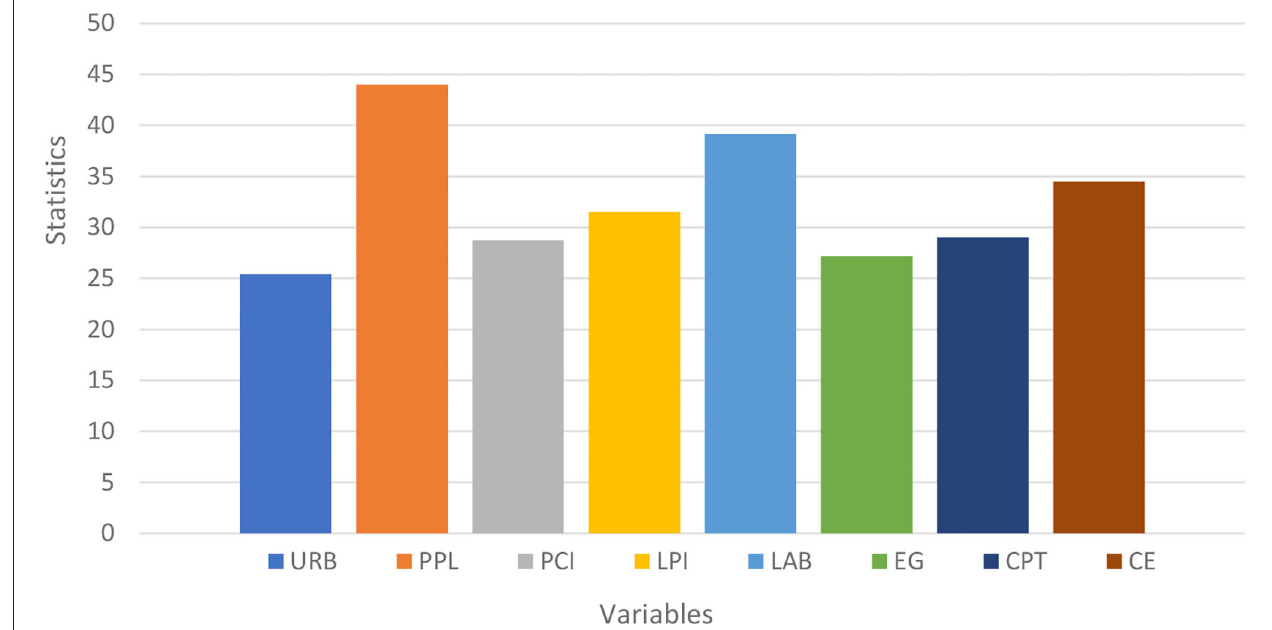
FIGURE 1 | Results of cross -sectional dependence